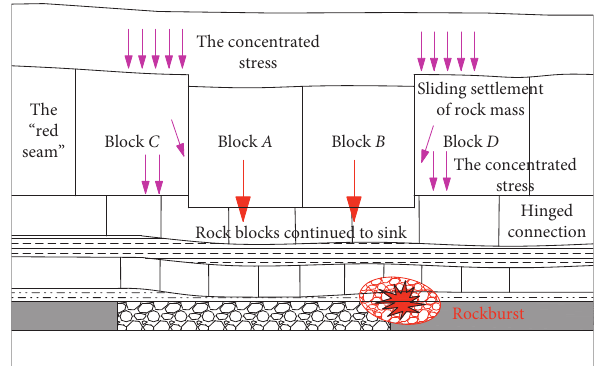
Figure 7: Schematic diagram of rockburst principle triggered by slip settlement of “red